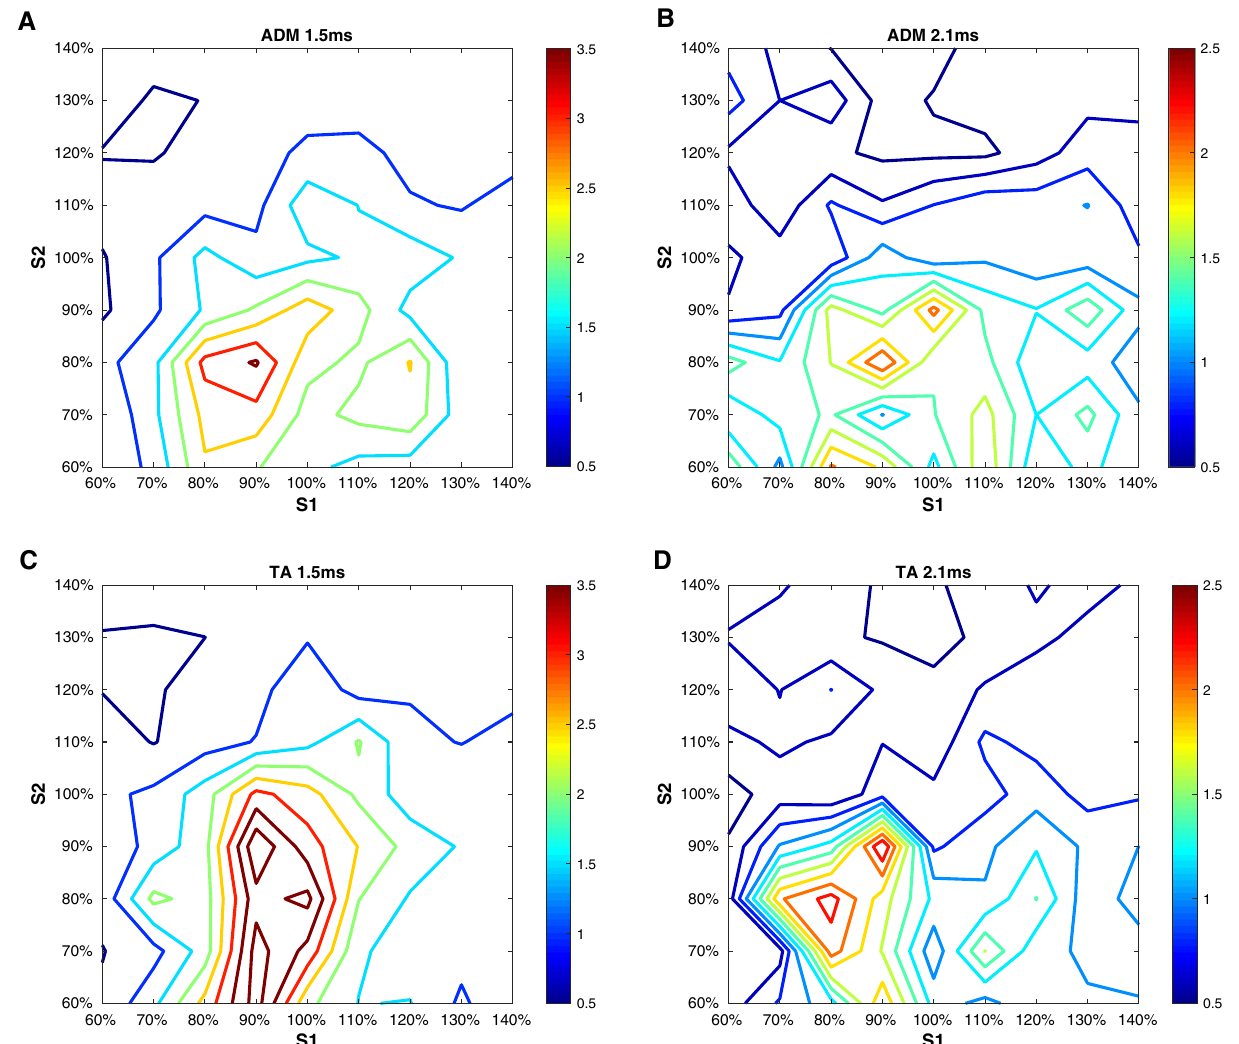
Figure 1. Short-interval intracortical inhibition and facilitation as a function of stimulus intensity and interstimulus interval in the resting abductor digiti minimi (ADM) and tibialis anterior (TA). ( A - B ) refer to the ADM at an interstimulus intervals (ISI) of 1.5 ( A ) and 2.1 ms ( B ). ( C-D) contain the data for the TA at an ISI of 1.5 ( C ) and 2.1 ms ( D ). In each plot, the stimulus intensity of the first stimulus (S1, x-axis) and the second stimulus (S2, y-axis) is related to the resting motor threshold (RMT) of the ADM ( A-B ) or the tibialis anterior ( C-D ). For each condition, the interaction between S1 and S2 is expressed as the percentage of motor evoked potential (MEP) amplitudes produced by paired TMS (MEP S1+S2 ) over the arithmetic sum of the MEP produced by the single stimuli (MEP S1 + MEP S2 ). Inhibitory (< 1.0) and facilitatory interactions (> 1.0) are color-coded (see color bars). Each plot shows the average data across 10 participants. The figure was created using Matlab (Mathworks, version corrected for multiple comparisons). For the ADM at the 2.1 ms ISI, the optimal stimulation condition induc- ing SICI in all participants was S1 = 80% RMT and S2 = 130% RMT, which suppressed the MEPs to 39 ± 16% ( p = 0.009, not significant when corrected for multiple comparisons). For the TA at the 1.5 ms ISI, the optimal stimulation condition inducing SICI in all ten participants was S1 = 70% RMT and S2 = 130% RMT, which suppressed the MEPs to 49 ± 20% ( p < 0.0006). For the TA at the 2.1 ms ISI, the optimal stimulation condition inducing SICI in all participants was S1 = 80% RMT and S2 = 130% RMT, which suppressed the MEPs to 37 ± 23% ( p = 0.005, not significant when corrected for multiple comparisons). When S1 was close to or equal to RMT and S2 was slightly below RMT, an excitatory interaction (i.e., SICF) of S1 and S2 occurred for both the ADM and TA muscles at the 1.5 ms ISI. The typical settings in upper limb